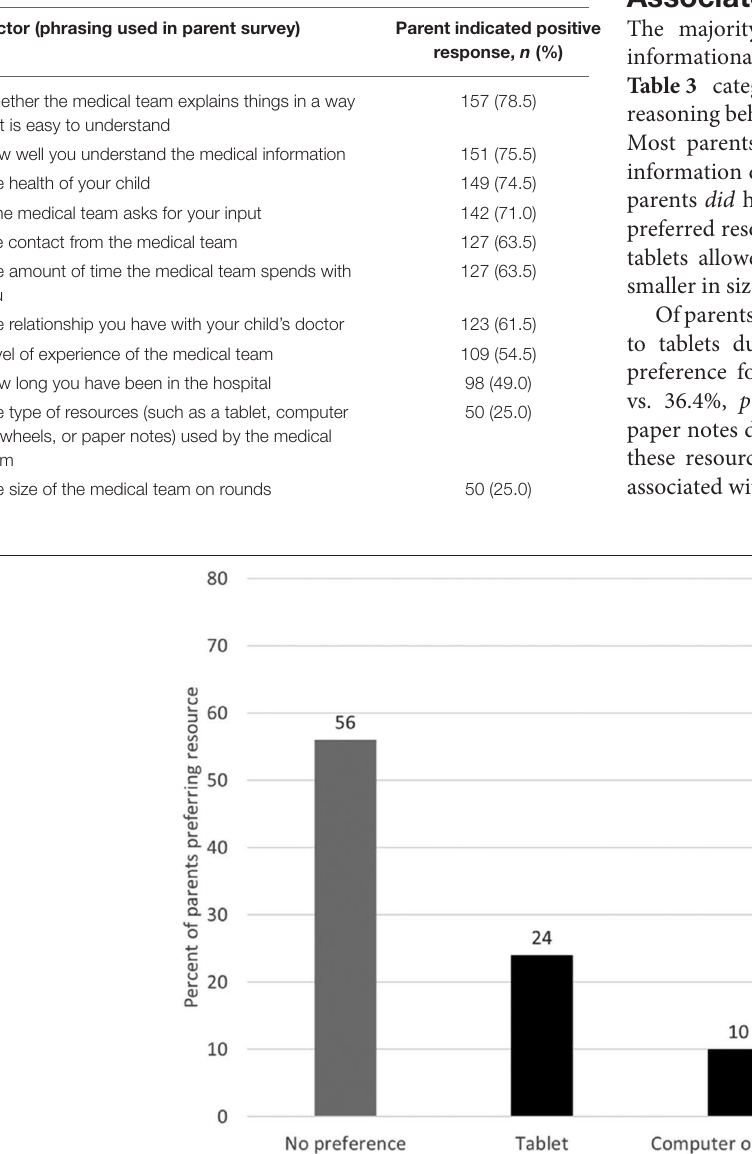
TABLE 2 | Parent perspectives on factors impacting participation in family-centered rounds ( n = 200).